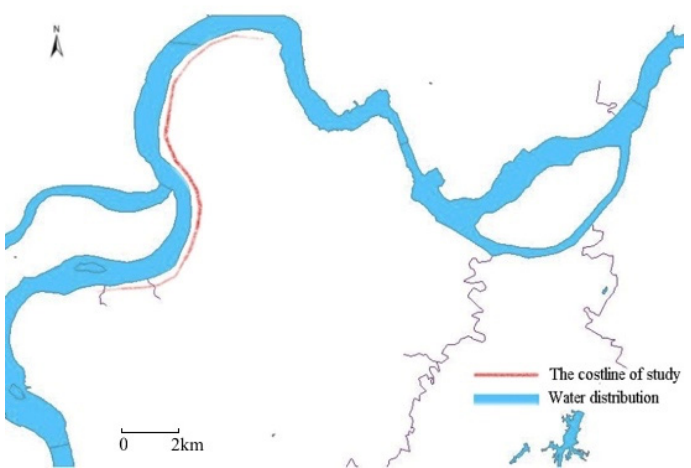
Figure 1. The water system distribution map of the main urban area of Chongqing.